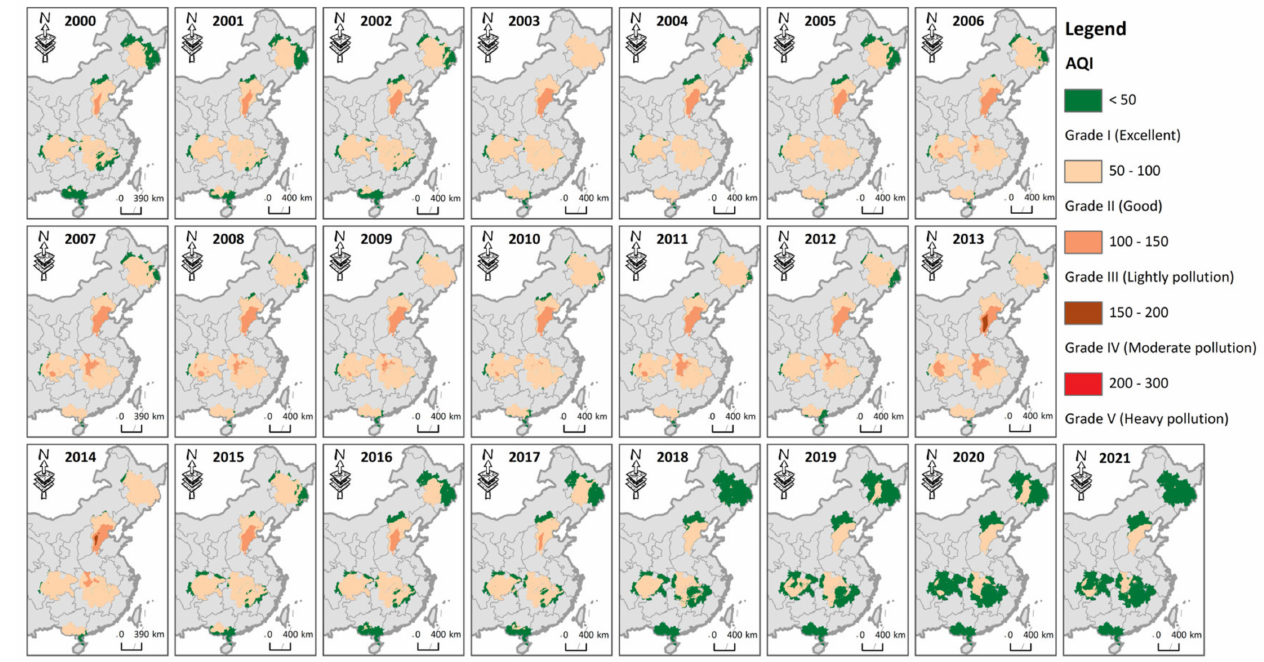
Figure 9. Spatial pattern of ambient air quality ( AQI ) in the five UAs over the period